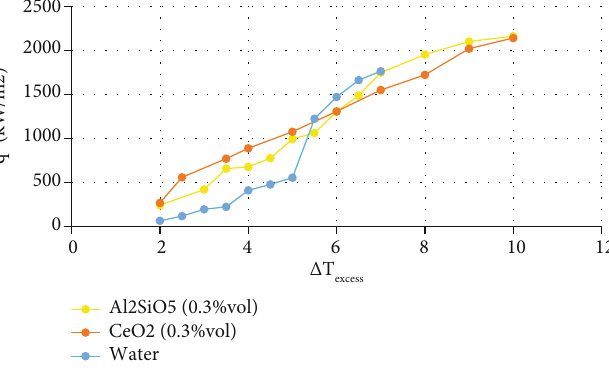
Figure 15: Heat fl ux comparison.